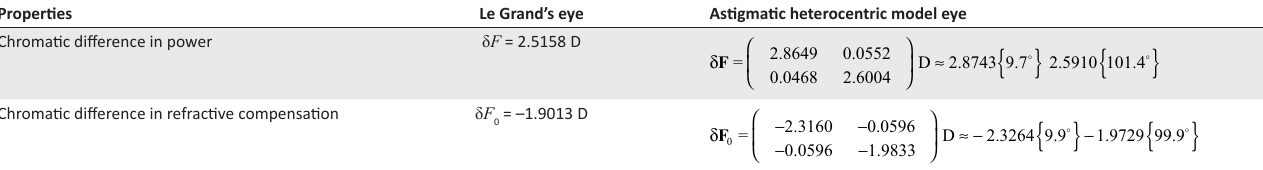
TABLE 1: Aperture-independent chromatic